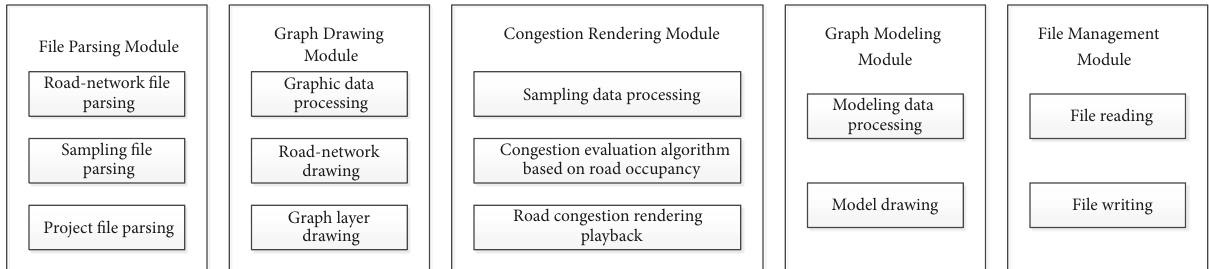
Figure 2: The framework for evaluating the performance of the proposed algorithm.